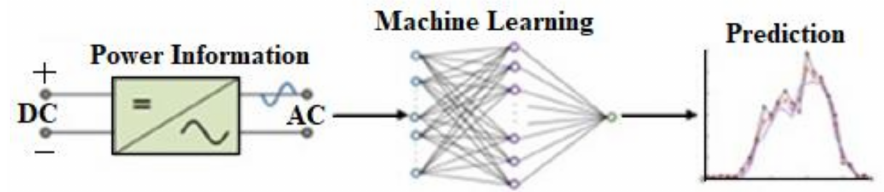
Figure 18. Machine learning approach.